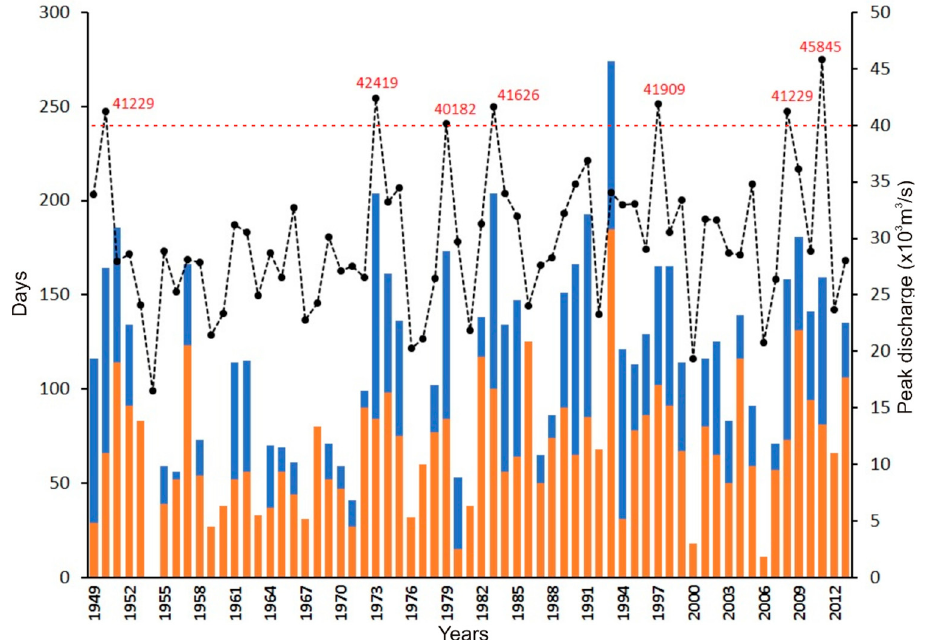
Figure 10. The peak discharges (black line with dots) at TBL from 1949 to 2013. The BCS was opened during every flood event except the 1993 flood [89] (see Table 5). In contrast, the duration of discharge from 18,000–32,000 m 3 /s is also marked on the histogram. Peak discharges during seven flood events above the red dashed line (40,000 m 3 /s) are marked with a red number. The duration in days of discharge from 18,000–25,000 m 3 /s (orange color, tending to deposition) and above 25,000 m 3 /s (blue color, tending to erosion) are also marked on the histogram. It is observed that the longest period (185 days) of deposition occurred during the 1993 flood, whereas the longest erosion duration (120 days) took place during the 1973 flood.